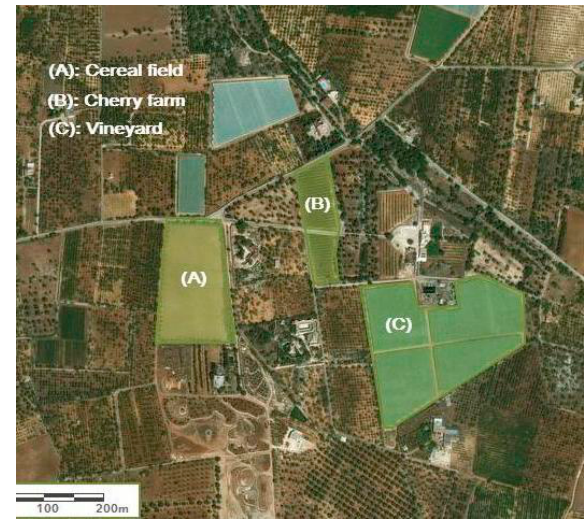
Figure 1. The area located at Turi in Puglia region, Southern Italy.